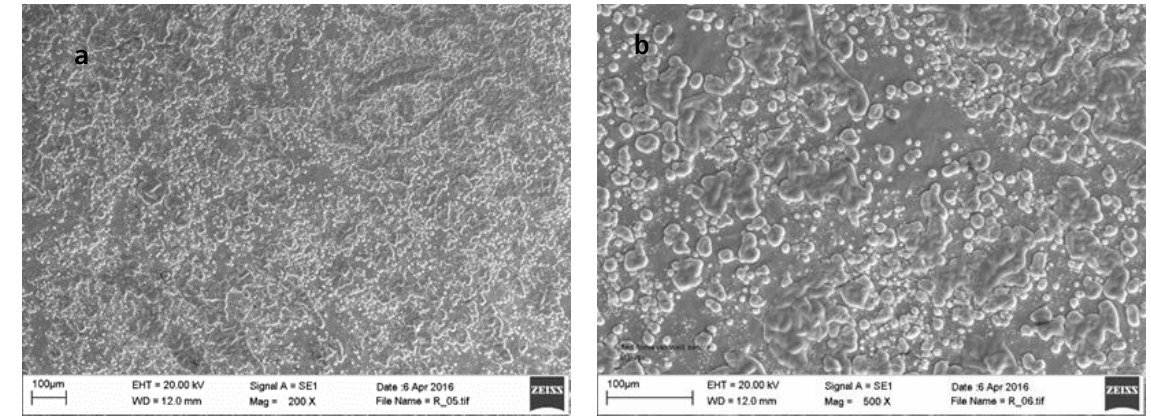
Figure 5. ’Red Rome van Well’ peel segment at 200x (a) and 500x (b) magnifications after